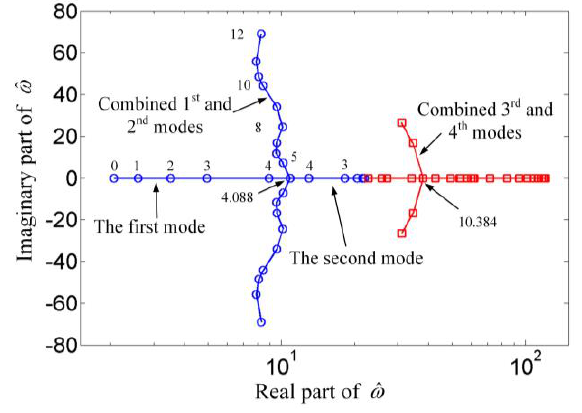
Figure 5. Dimensionless complex frequencies of the suspended microchannel resonator as a function of the dimensionless flow velocity for β 2 =1.6 .